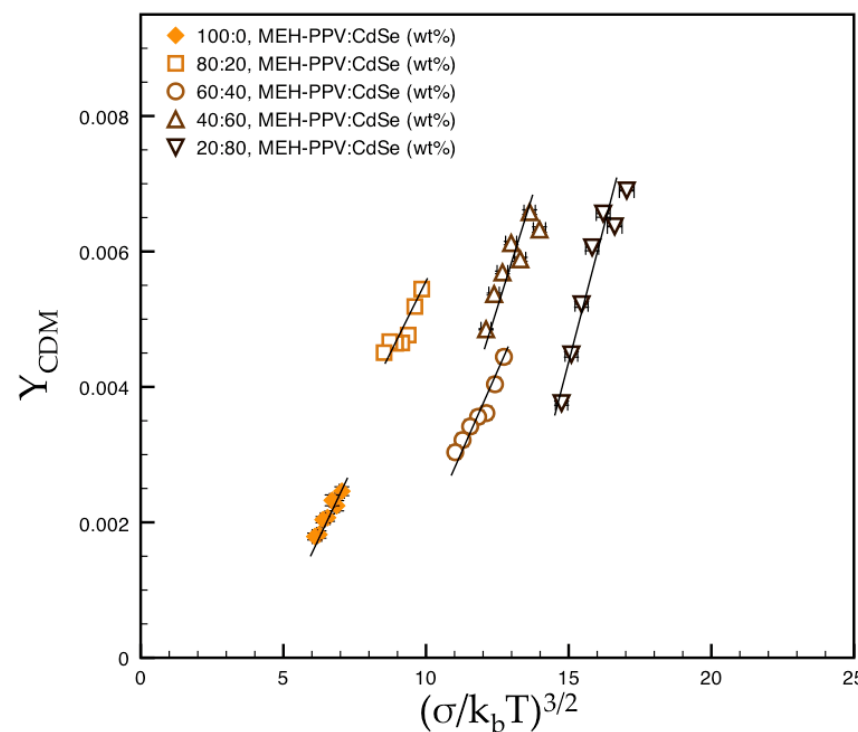
, as a function of the CDM T . b